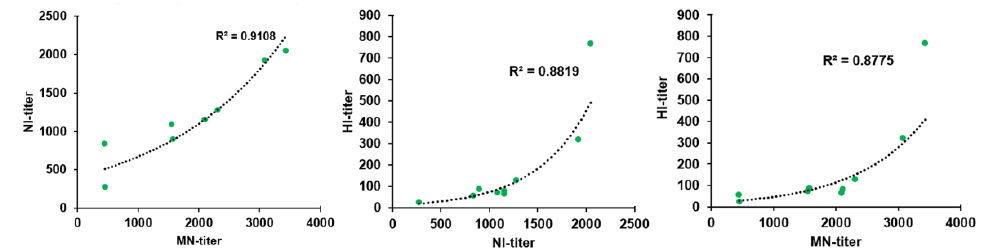
Figure 6. Correlation analysis among different antibody titers at day 21 post the last immunization. Correlation among HI/NI/MN antibody titers using the fitted curves. R 2 indicates the goodness of the fit.